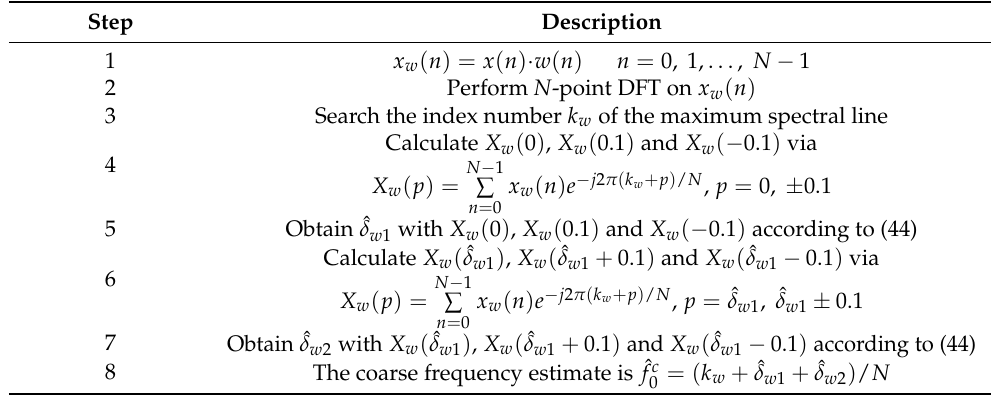
Table 1. Coarse frequency estimation